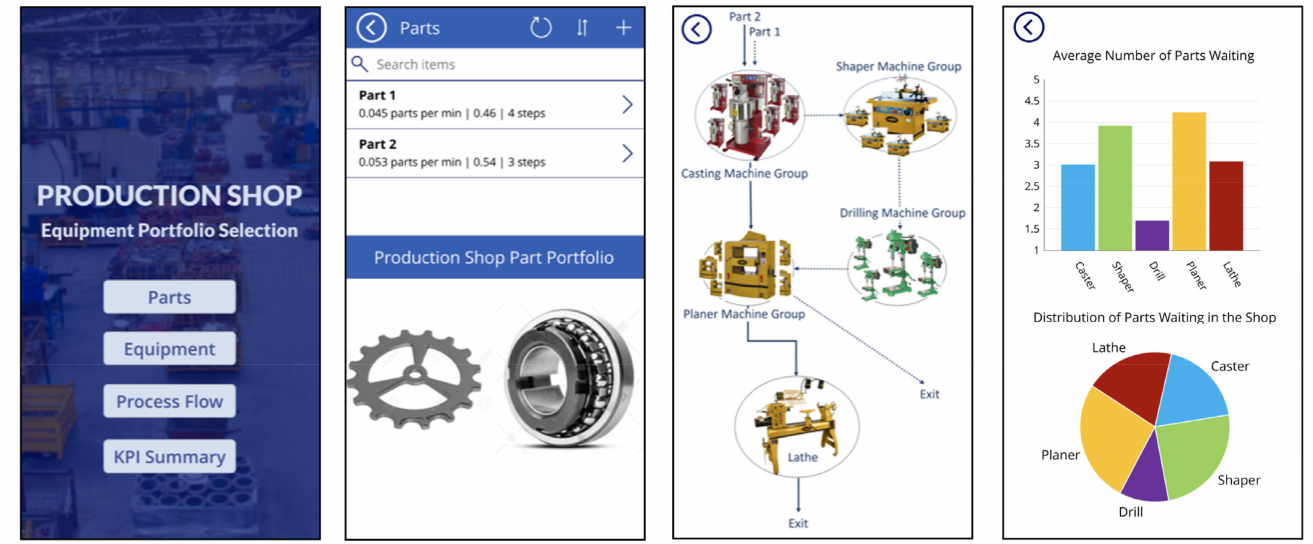
Figure 9. An application of production shop simulation in Microsoft Power